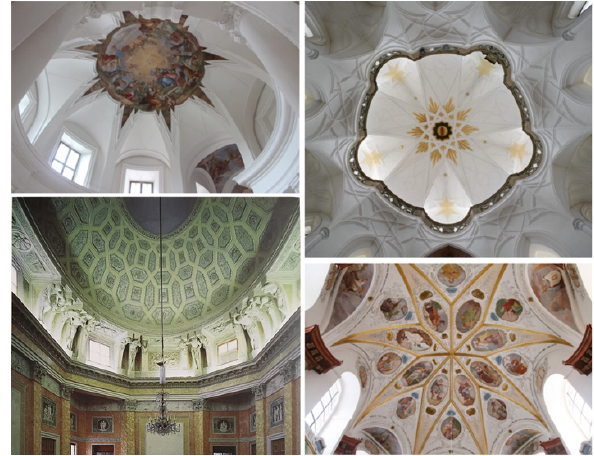
Figure 8. Examples of star vaults – St. Bernard’s Chapel (CZ, top left), Church of St. John Nepomuk (CZ, by Čapková, top right), Cattaneo Palace (IT, bottom left), and Chapel of the Epiphany of Our Lord (CZ, by Peška, bottom right)